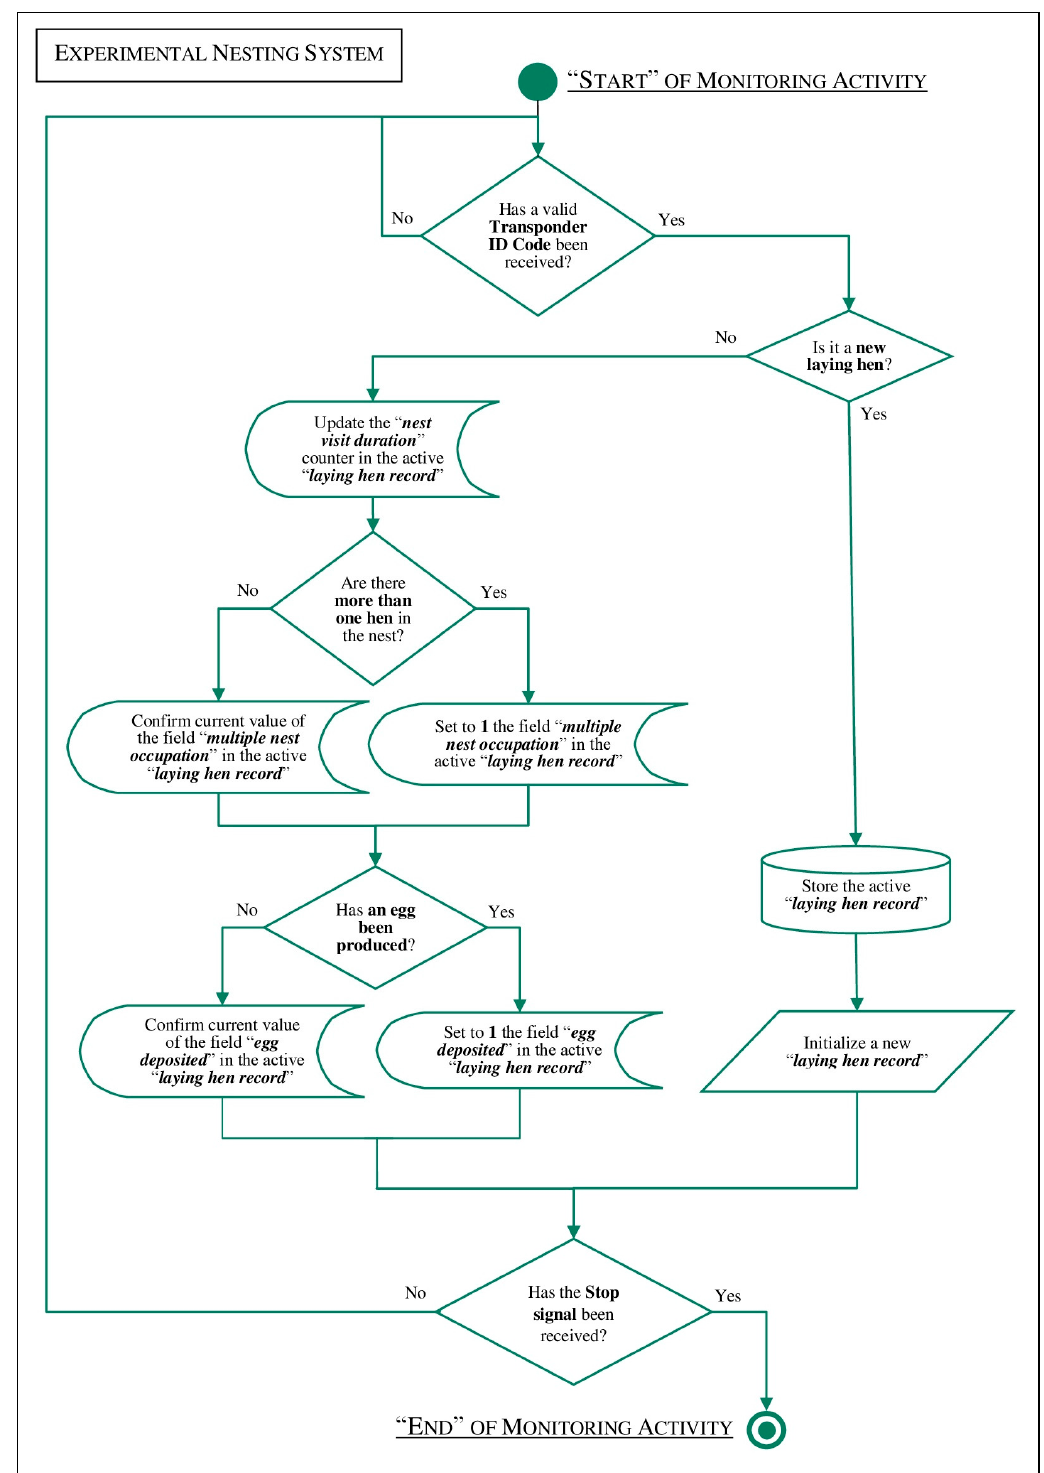
Figure 2. Flow diagram of the software application developed for the experimental nesting system.